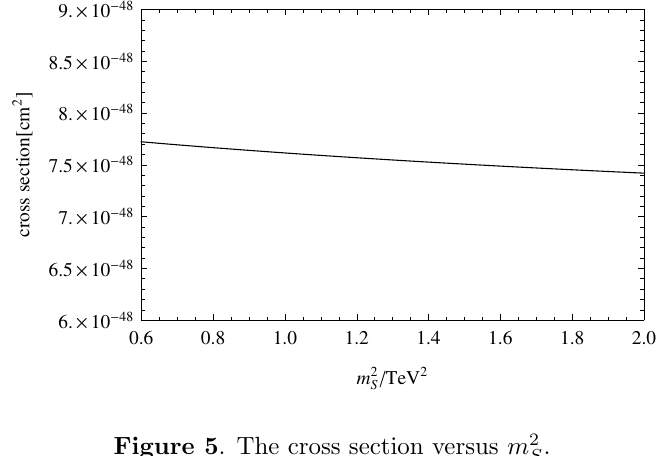
Figure 5 . The cross section versus m 2